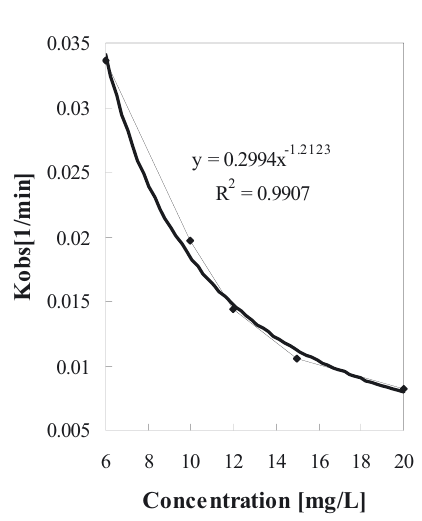
Figure 5. The relationship between K